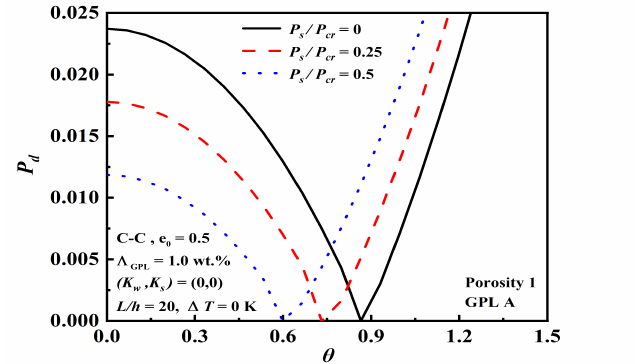
Figure 14. Effect of static axial compressive force P s / P cr on dynamic instability.